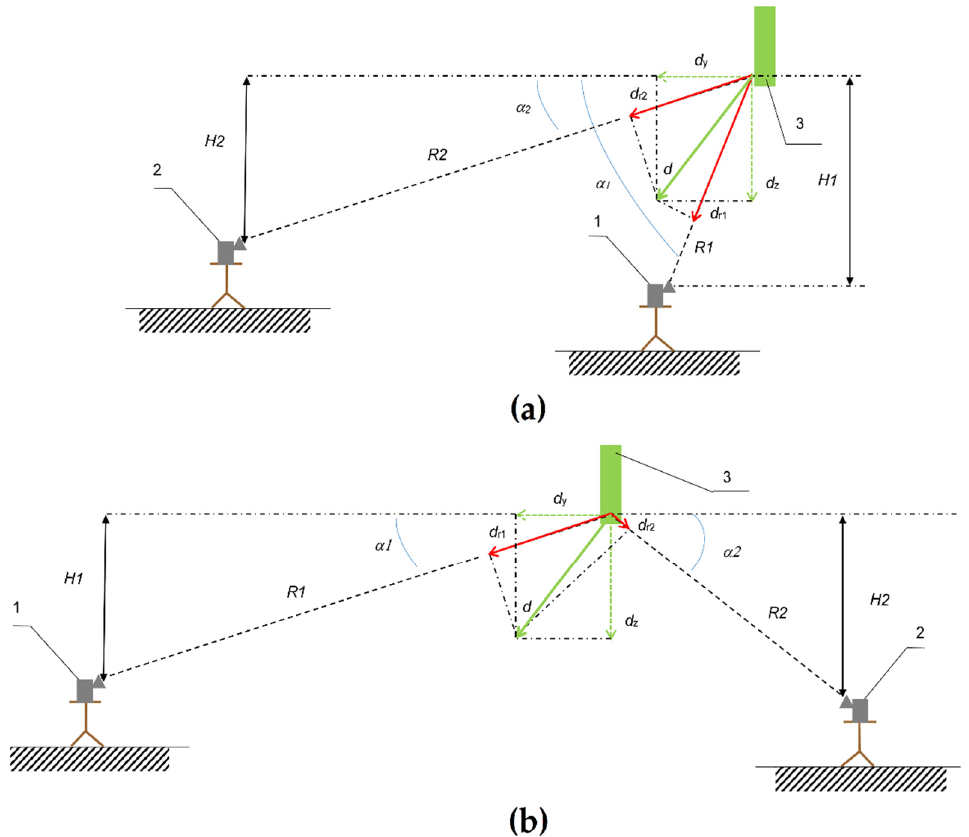
Figure 3. Vertical and horizontal displacement measurement using a set of two interferometric radars: ( a ) two radars at the same side of measured element, ( b ) two radars at both sides of measured element; 1 and 2—interferometric radars, 3—tested element of the bridge, d —total displacement, d z —vertical component of total displacement, d y —horizontal component of total displacement, d r1 and d r2 —displacements in the range direction, R 1 and R 2—radar distance from the tested point in the target axis, H 1 and H 2—distance from the tested point in vertical/horizontal